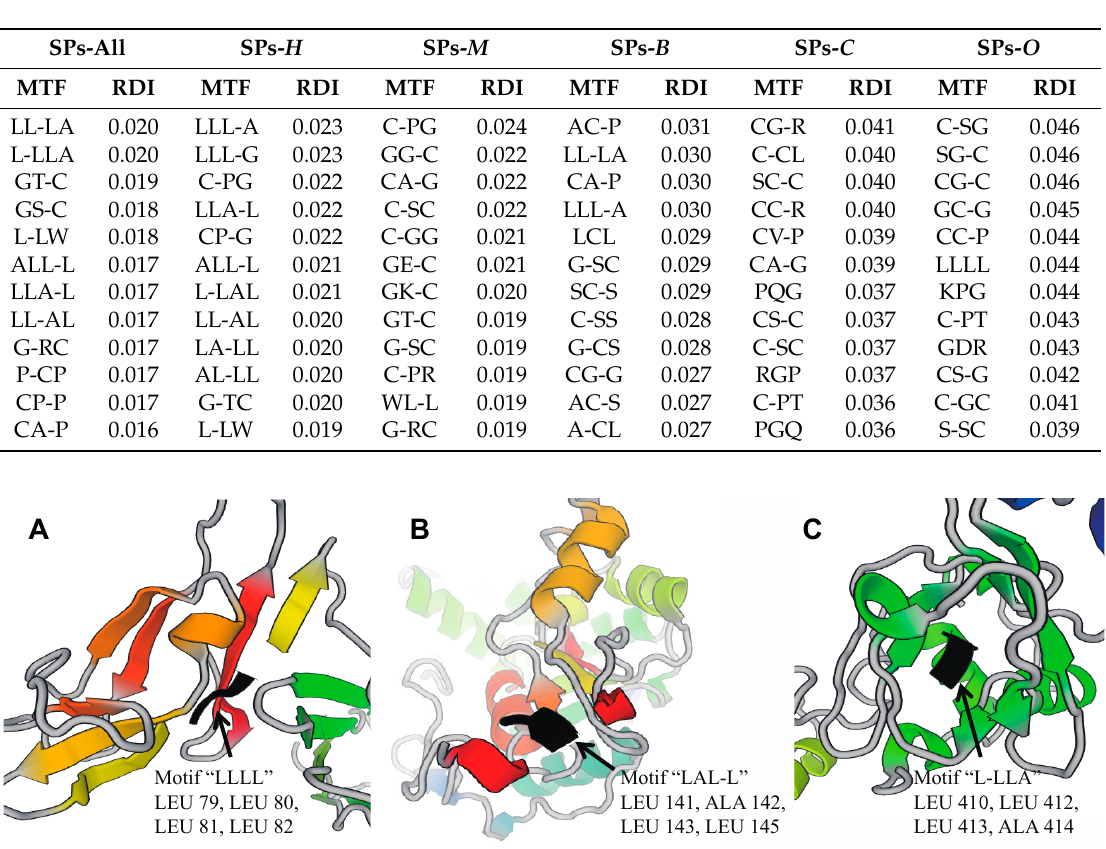
Figure 3. Example of leucine-rich motifs in mammalian secreted proteins. Panels ( A – C ) are captured from protein 3D structure 4GRW (human IL-23 with 3 Nanobodies), 1T8T (human 3- O- Sulfotransferase-3 with bound PAP), and 5NV6 (human transforming growth factor beta-induced protein), respectively.